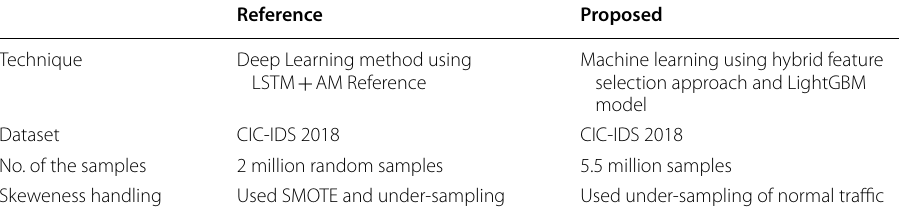
Table 16 Comparison of the methodology of the proposed model with the deep learning model by Lin et al.